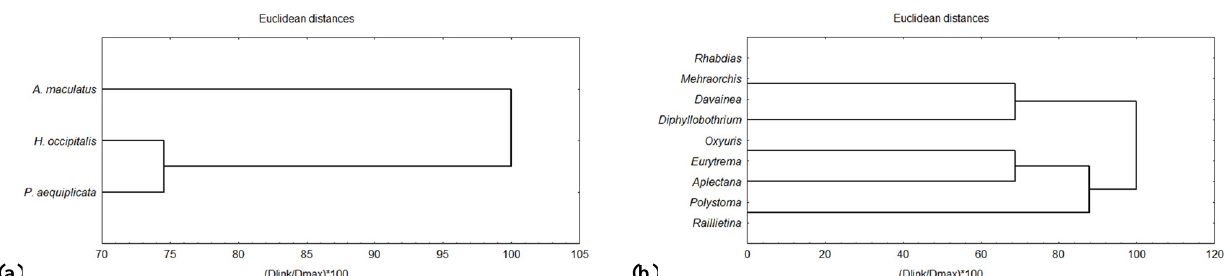
Figure 1. UPGMA dendrograms (standardized to 100%) showing dissimilarity between host-anuran species in terms of their helminth communities (a) , and among helminth species in terms of their associations with the three studied anuran species (b)